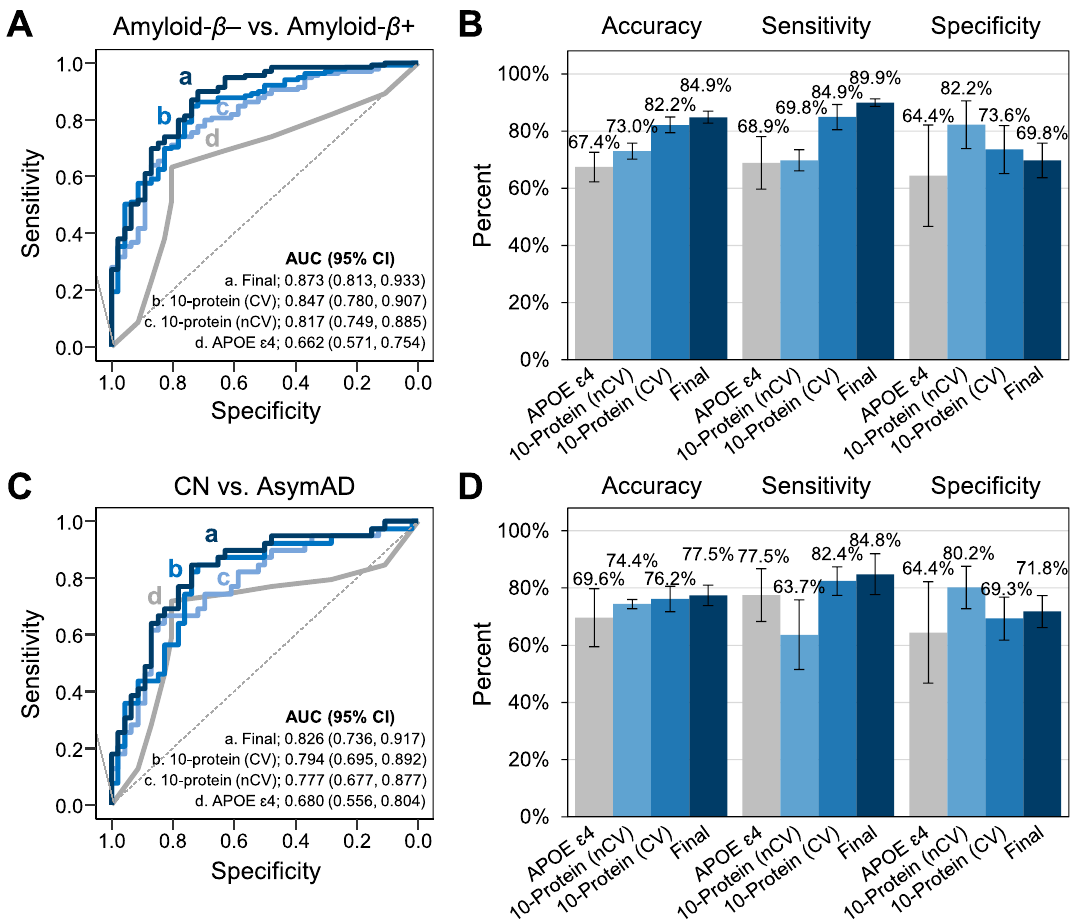
Figure 3. Protein model combined with clinical value for predicting amyloid beta-positive and -negative groups. ( a ) ROC curves for 10 proteins performed with nested crossvadation, 10 proteins performed with fivefold crossvalidation, APOE ɛ 4 carriers, and final AD model (all combined) predicting amyloid β -positive and -negative groups. Area under the curve (AUC) and 95% CI of AUC values for each model are shown. ( b ) Sensitivity and specificity plots for the 4 models predicting amyloid β -positive and -negative groups. Error bars represent 95% confidence interval. ( c ) ROC curves of 10 proteins performed with nested crossvadation, 10 proteins performed with fivefold crossvalidation, APOE ɛ 4 carriers, and final AD model (all combined) predicting “CN” and “AsymAD” groups. AUC value and 95% CI of AUC values for each model are shown. ( d ) Sensitivity and specificity plots for the 4 models predicting “CN” and “AsymAD” groups. Error bars represent 95% confidence